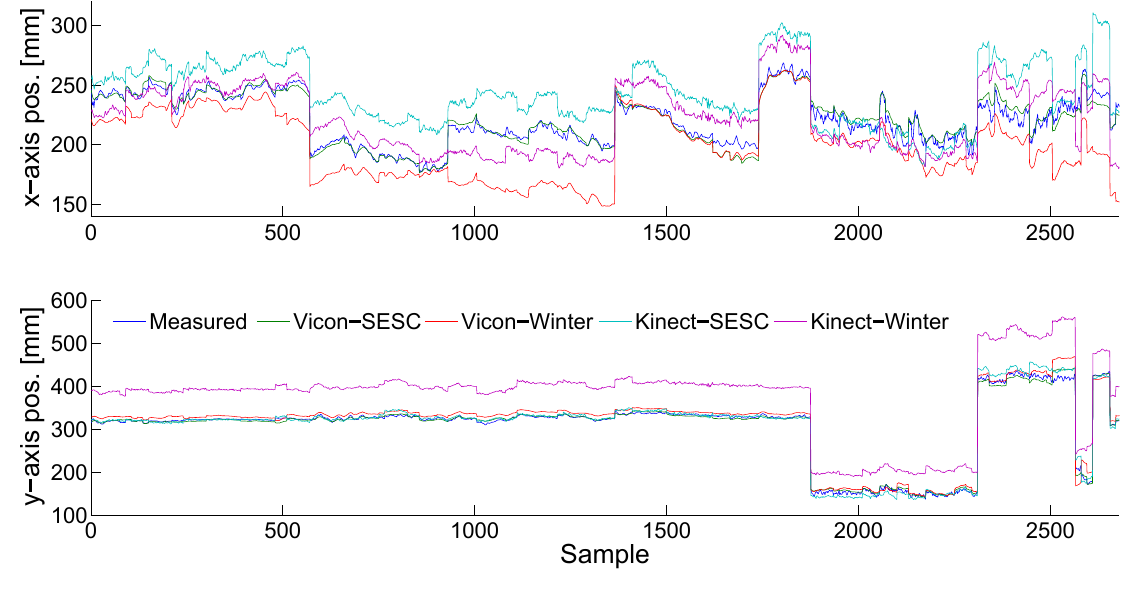
Figure 3. Estimation results for Sb03’s. Measured CoP from the AMTI6 platform is shown as a dark blue line. CoM estimation using Vicon and Kinect SESCs are shown in green and light blue lines, respectively. The estimations performed using an anthropometric table [10] with Vicon and Kinect are shown in red and violet, respectively.